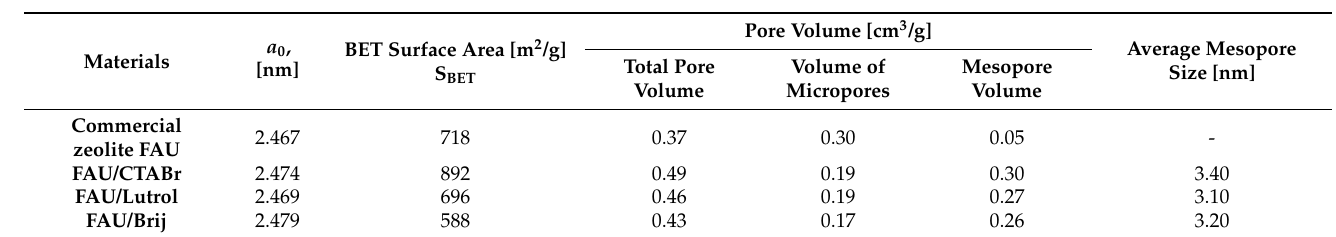
Figure 1. Small-angle ( A , B ) and wide-angle ( C , D ) diffractograms of hierarchical materials based on FAU-type commercial zeolite before and after curcumin loading along with spectra of the FAU-type commercial zeolite and the active substance standard. Table 2. Selected textural properties of hierarchical materials based on commercial zeolite type FAU (cid:113) ( h 2 + k 2 + l 2 ) × λ 2 ( a 0 —unit-cell size assessed from XRD, a 0 = 4 sin 2 θ